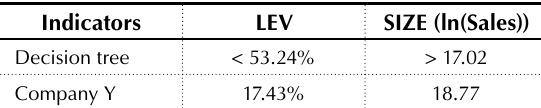
Table 5. Parameters of company Y compared